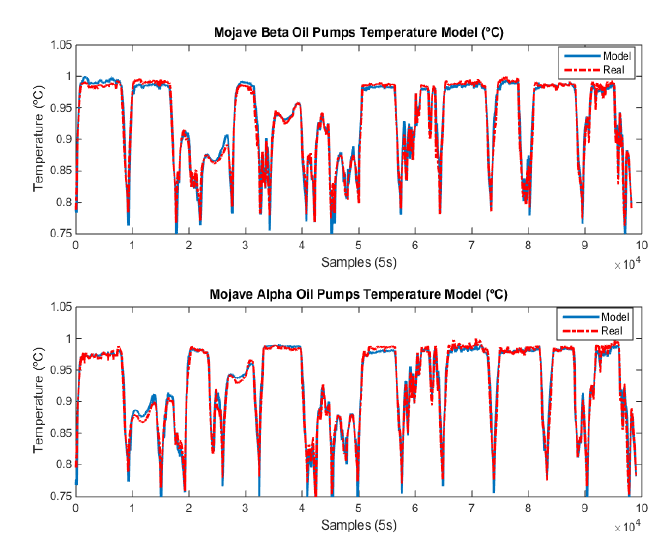
Figure 17. Mojave Beta: Oil Pumps Temperature: ( top ) Mojave Beta model, showing real evolution (red dash-dotted) and model output (blue solid); and ( bottom ) Mojave Alpha model, showing real evolution (red dash-dotted) and model output (blue solid).